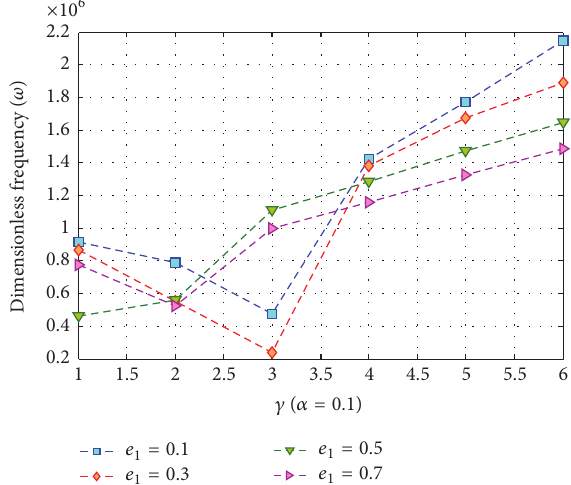
Figure 3: Effect of porosity and aspect ratio on dimensionless natural